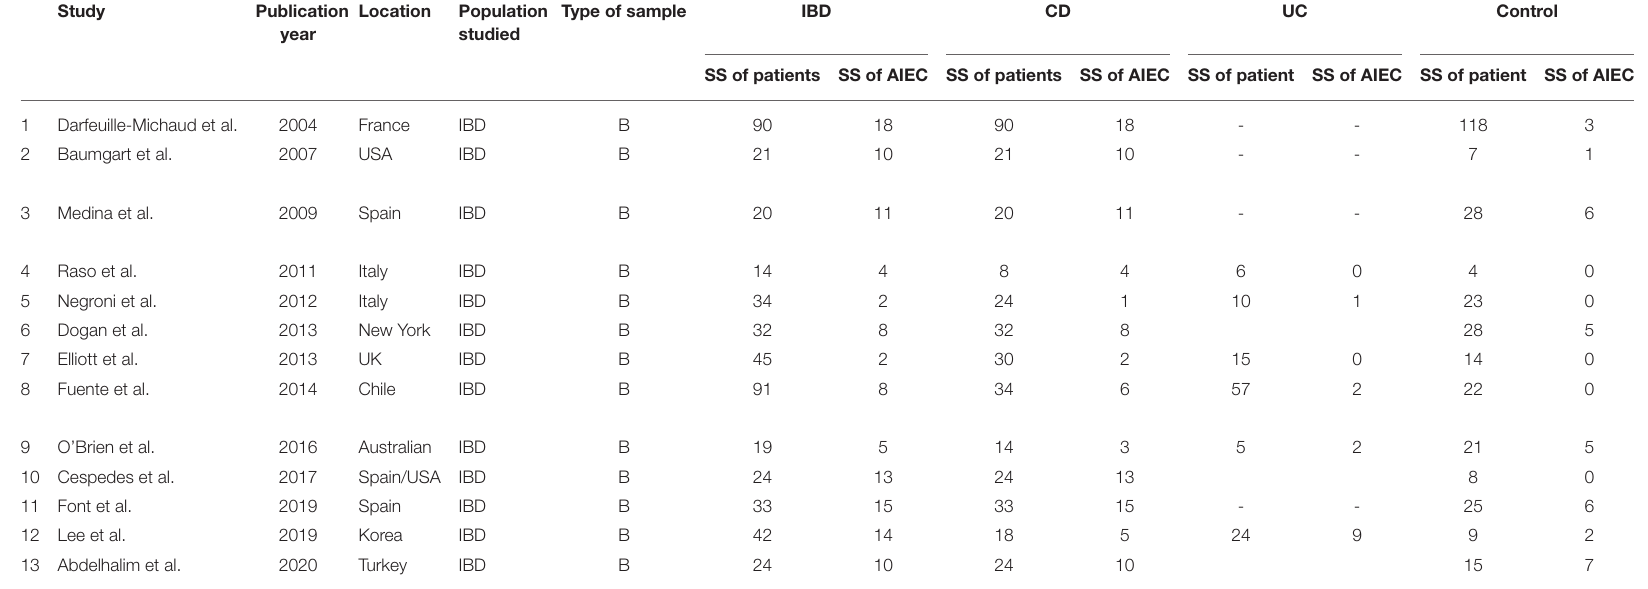
TABLE 1 | The characteristics of studies included in the systematic